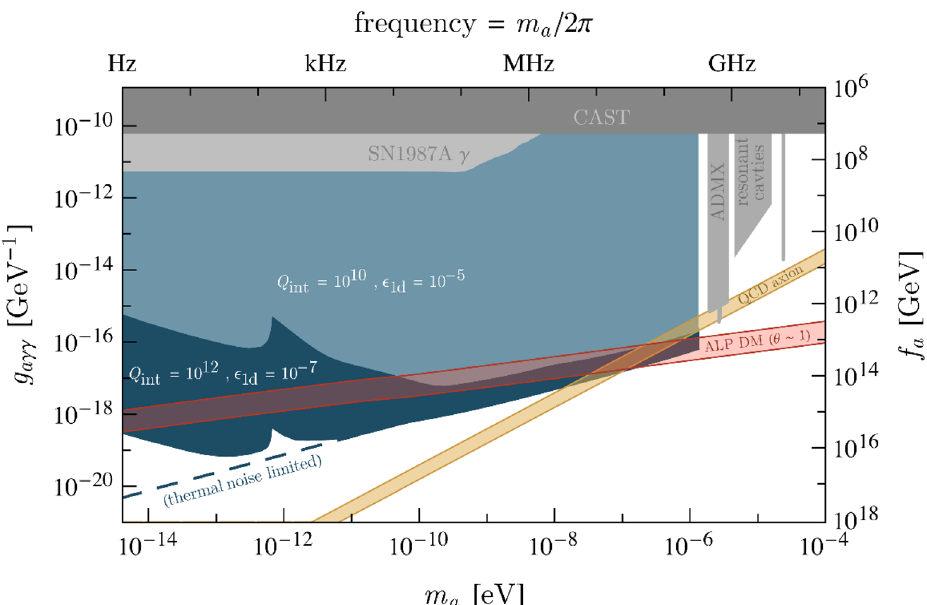
perimental con(cid:12)gurations, compared to existing constraints, shown in gray. Along the right axis, we relate the axion-photon coupling to the symmetry breaking scale f a by g a(cid:13)(cid:13) (cid:24) (cid:11) em = 2 (cid:25)f a . As two representative examples, we show the projected sensitivity assuming an intrinsic quality factor and readout-pump mode coupling (see section 5.2) of Q int = 10 10 , 10 12 and (cid:15) 1d = 10 (cid:0) 5 , 10 (cid:0) 7 , respectively. The dashed line shows the thermal noise limited sensitivity for Q int = 10 12 and (cid:15) 1d = 10 (cid:0) 7 . In all cases, we assume a pump mode frequency of ! 0 = 2 (cid:25) = GHz, a cavity volume of V = 1 m 3 , a peak magnetic (cid:12)eld of B 0 = 0 : 2 T, a mode overlap of (cid:17) 10 = 1 (see eq. (3.10)), a cavity temperature of T = 1 : 8 K, an average wall displacement of q rms = 10 (cid:0) 1 nm (as de(cid:12)ned in section 5.3), and an e -fold time of t e = 10 7 s. The orange band denotes the range of couplings